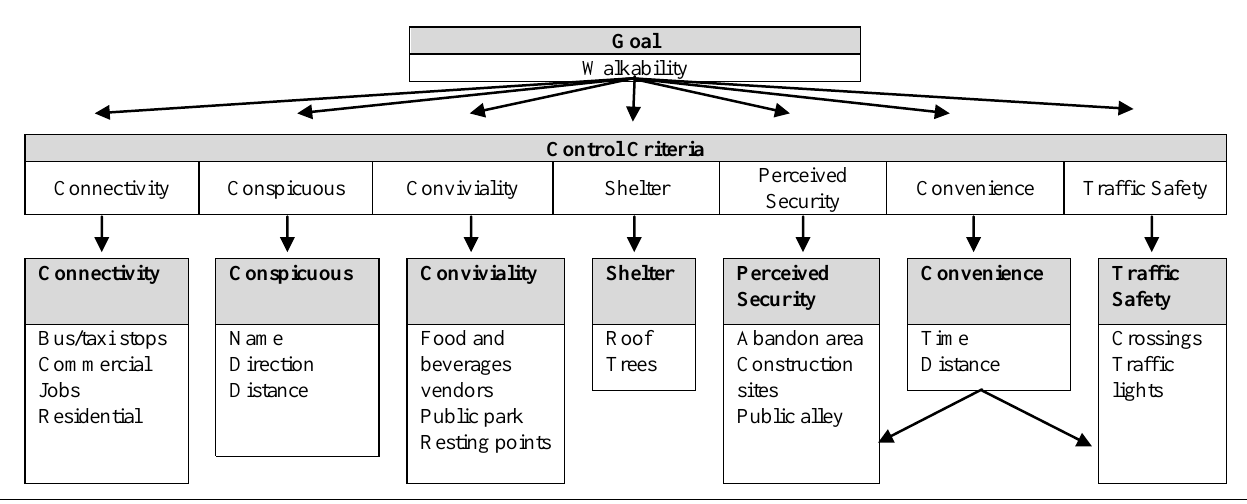
Figure 5: ANP Model showing the Dependencies between the Criteria